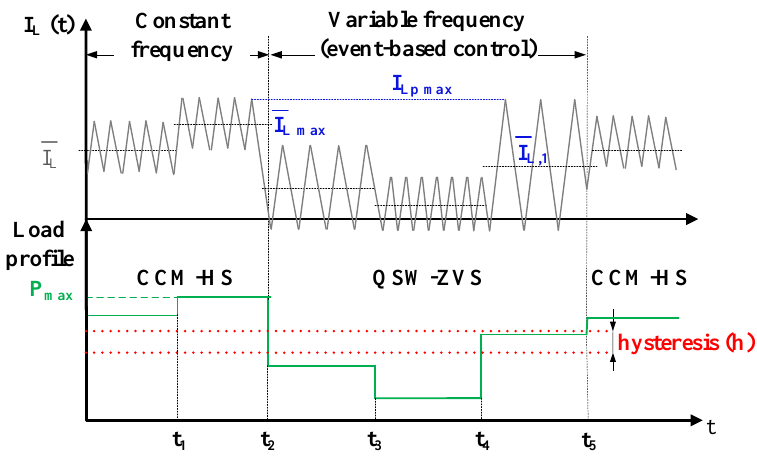
Figure 6. Example of switching among modes strategy depending on the load.